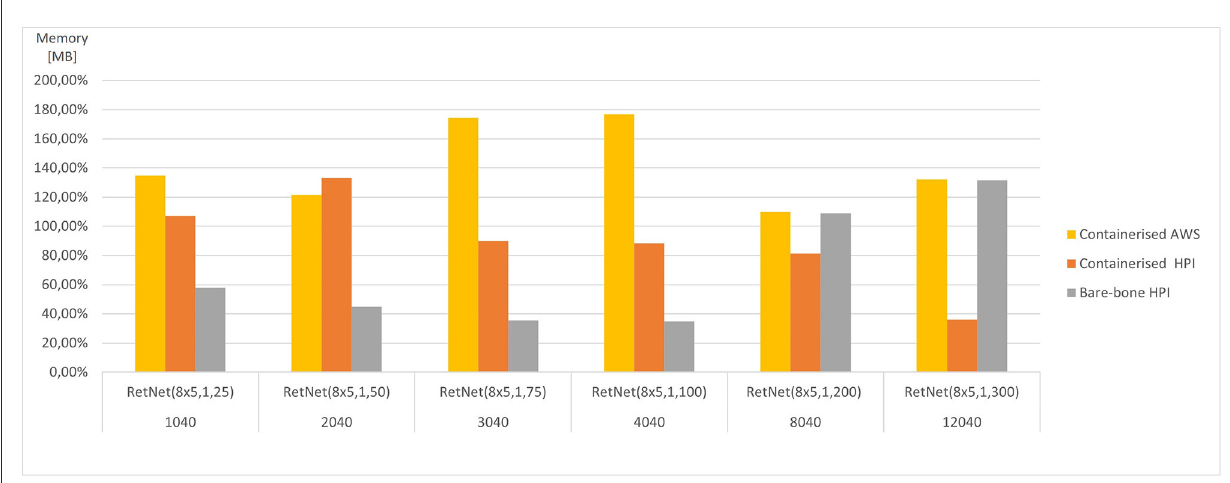
FIGURE6 Average memory consumed for each RetNet model (ranging in complexity from 1,040 to 12,040 Hodgkin–Huxley neurons) viewing three input patterns (0, A, 1), expressed as a percentage of average memory utilization across all execution environments for each RetNet model, based on Tables 2, 3.